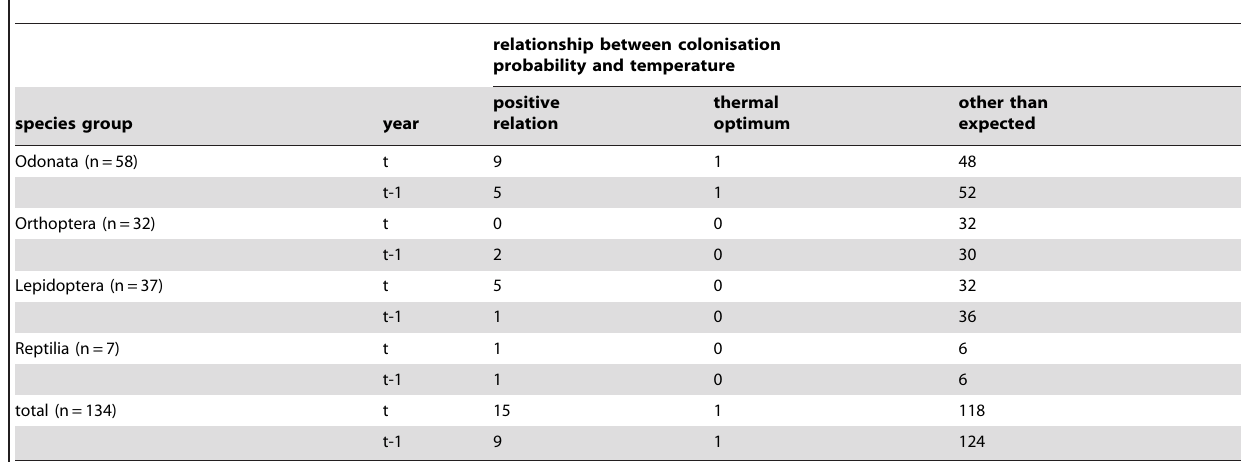
Table 2. Number of species by group that show given relationships between colonisation probability and temperature in current or preceding year.